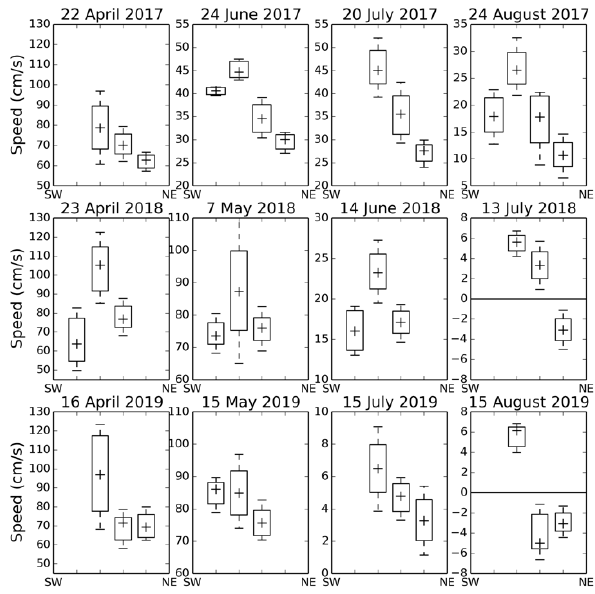
Figure 2. Observations of drifter speeds sampled in the Trent River from 2017 to 2019. Drifter data binned into approximate 50 m wide cross-stream bins (some bins had no drifter data).